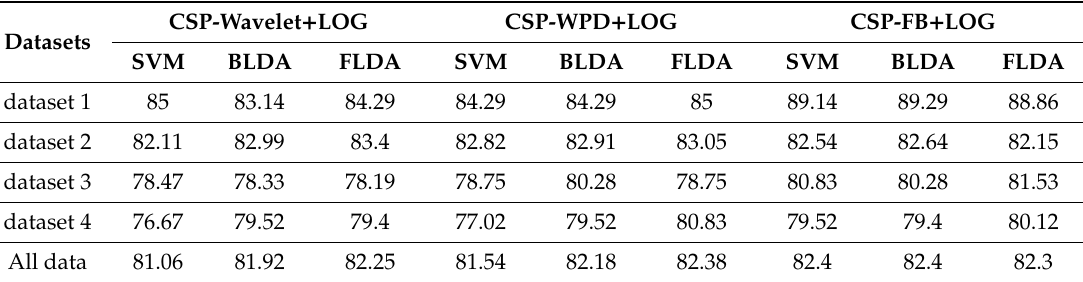
Table 9. The e ff ect of di ff erent classifiers on average classification accuracy of various datasets.